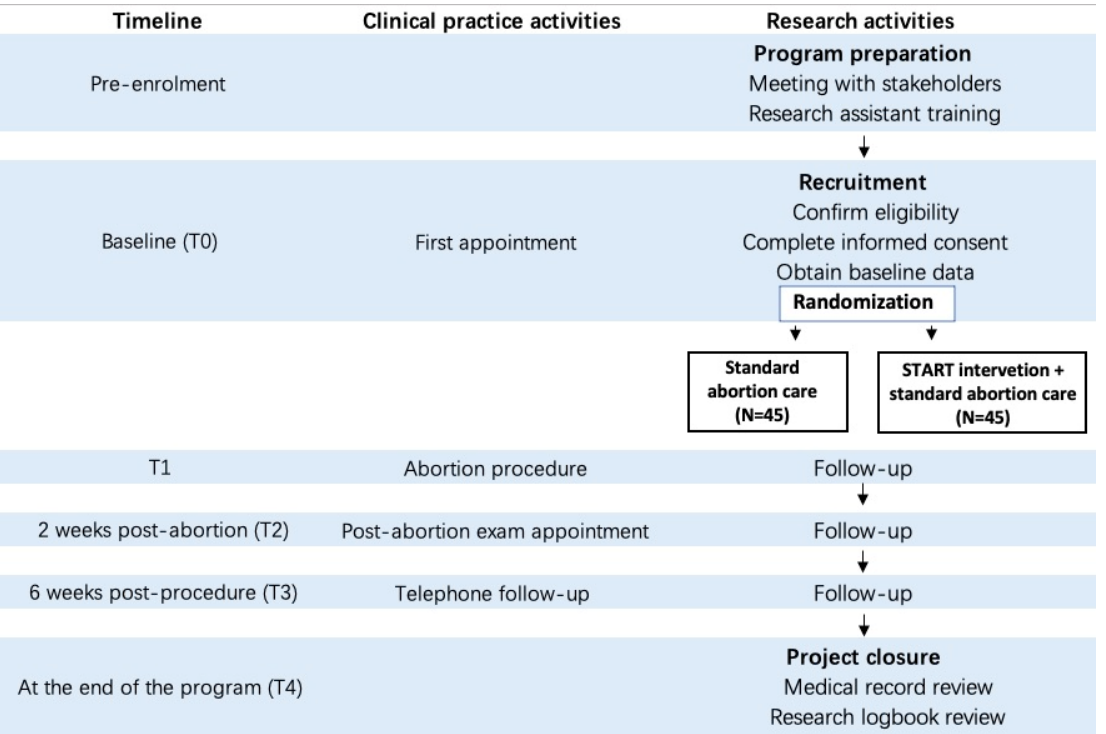
Figure 2. SPIRIT standard flow diagram.